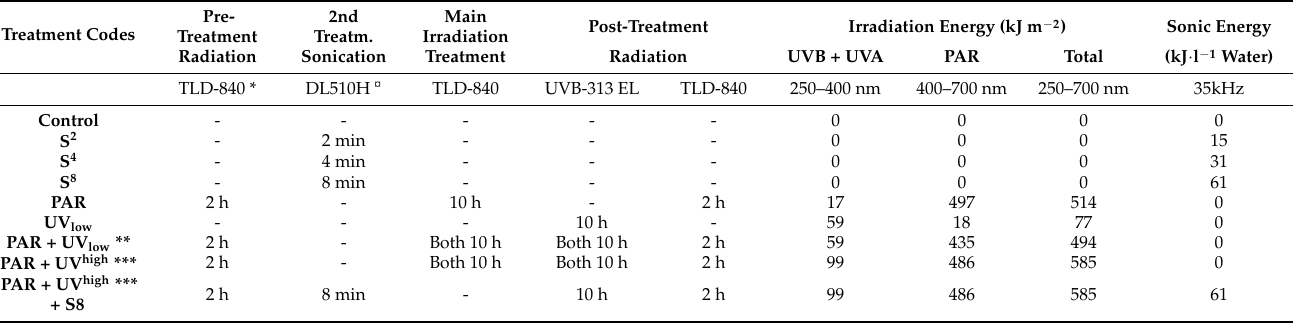
Table 1. Four-step elicitor treatment of white cabbage waste fraction leaves in comparison with control (non-treated). Leaves were exposed at a 65 cm distance from the irradiation source with a UV-C filter between lamps and the leaves. Samples were exposed (for min or h) or non-exposed (-) to one or more of the elicitors steps as follows: step (1) 2 h irradiation treatment; step (2) sonication for 2, 4 or 8 min; step (3) 10 h main irradiation; and step (4) 2 h of post-treatment irradiation. A final period of 4–5 h in darkness was given prior to sampling for analysis (total 18–19 h). Treatment codes: S = ultrasound sonication; PAR = photosynthetic active radiation (irradiation from TLD-840 lamps); UV = ultraviolet irradiation (from UVB-313 EL lamps, at low or high level). The irradiation spectral distribution is shown in Figure